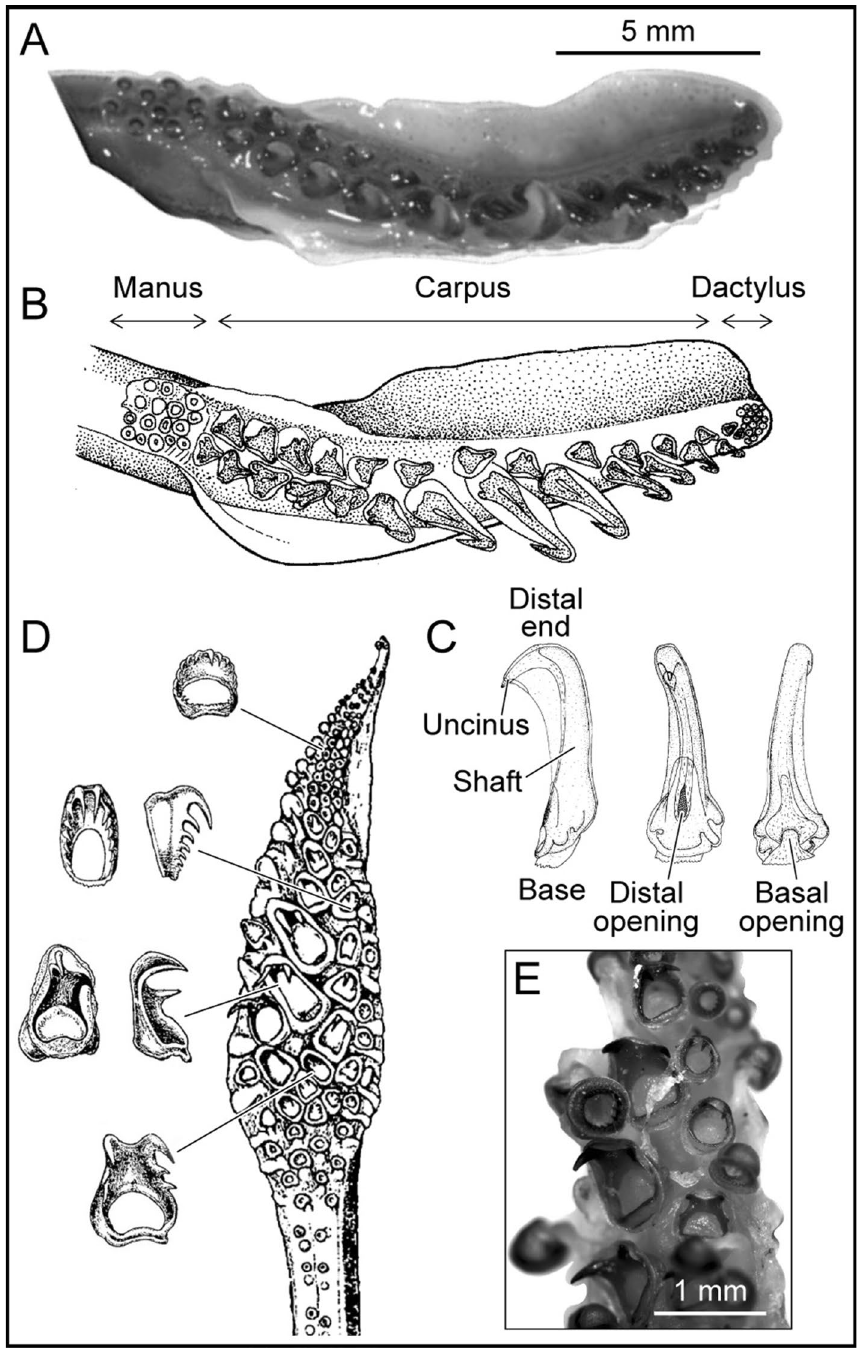
Figure 4. Examples of modern tentacular clubs and their armature. ( A ) Onychoteutis banskii left tentacular club, YPM 17906. ( B ) Sketch of a Onychoteutis banskii left tentacular club, modified from Roper et al. 66 . ( C ) Hook of Onychoteuthis banskii with soft tissues modified from Kulicki & Szaniawski 34 . From left to right: lateral view, outer side view and inner side view. ( D ) Sketch of a Taonius pavo right tentacular club with various modified suckers, after Sasaki 37 . ( E ) Taonius pavo left tentacular club manus, YPM 37340. In all specimens the base of the hooks is open on two sides (basal and